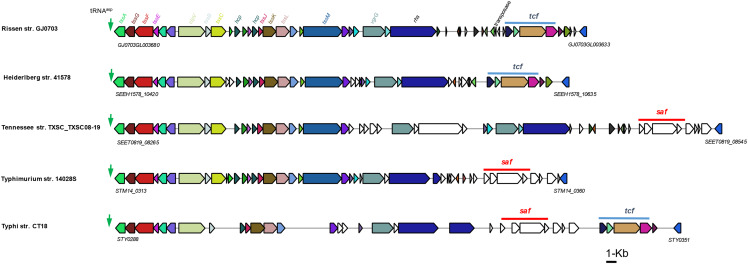
Schematic of the genetic organization of SPI-6 carrying T6SS. A genetic deletion involved the saf-associated gene cluster was found compared with strain CT18. The SPI-6 homologs of S. Rissen were collinearly compared with the counterparts in the genomes of strains Typhi CT18, Heidelberg 41578, Tennessee str. TXSC_TXSC08-19 and Typhimurium 14028S. The genes of mosaic SPI-6 homologs identified in a variety of Salmonella genomes were color coordinated, whereas specific genes and genome contexts were indicated by white.